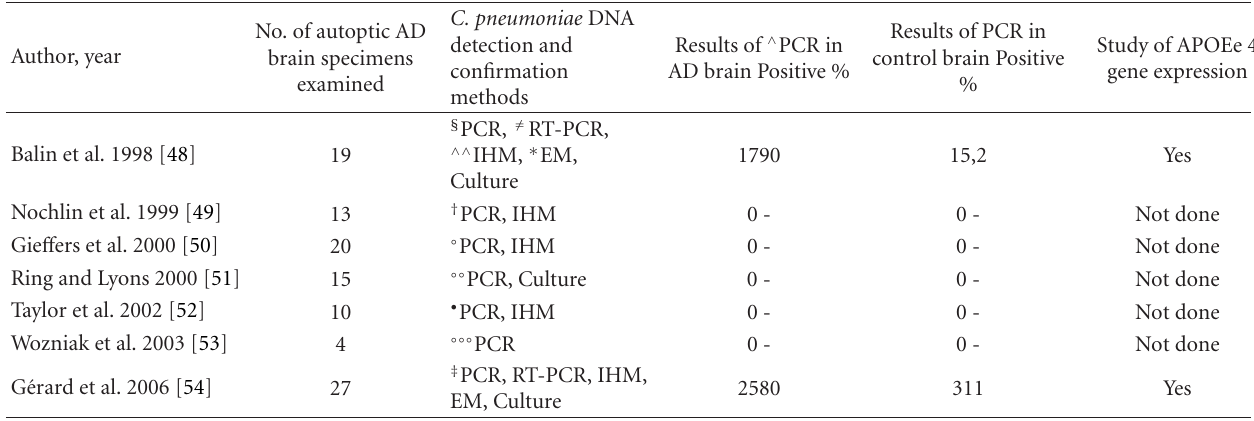
Table 1: Studies demonstrating evidence or absence of C. pneumoniae in brain autoptic specimens from patients with Alzheimer disease.